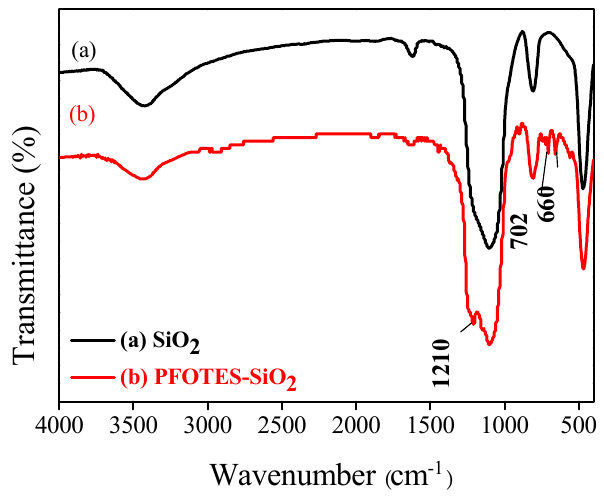
Figure 1. FTIR spectra of ( a ) SiO 2 , ( b ) PFOTES–SiO 2 . The influence of the mass ratio of PFOTES-SiO 2 to PVDF on the wettability is investi- gated. The surface wettability of PVDF/PFOTES-SiO 2 coatings with different mass ratios is tested with a contact angle measuring instrument, and the results are shown in Figure